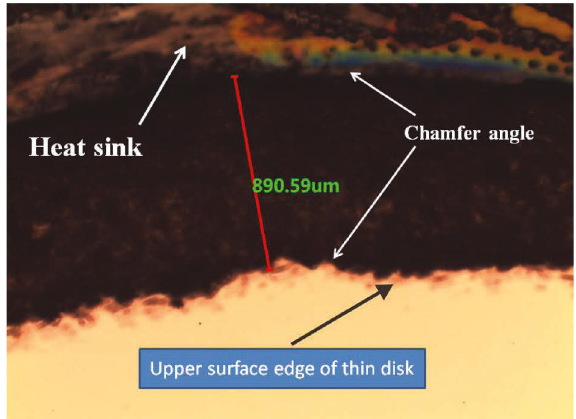
Figure 8: The edge of the disc crystal after chamfering with a magnification of 100.